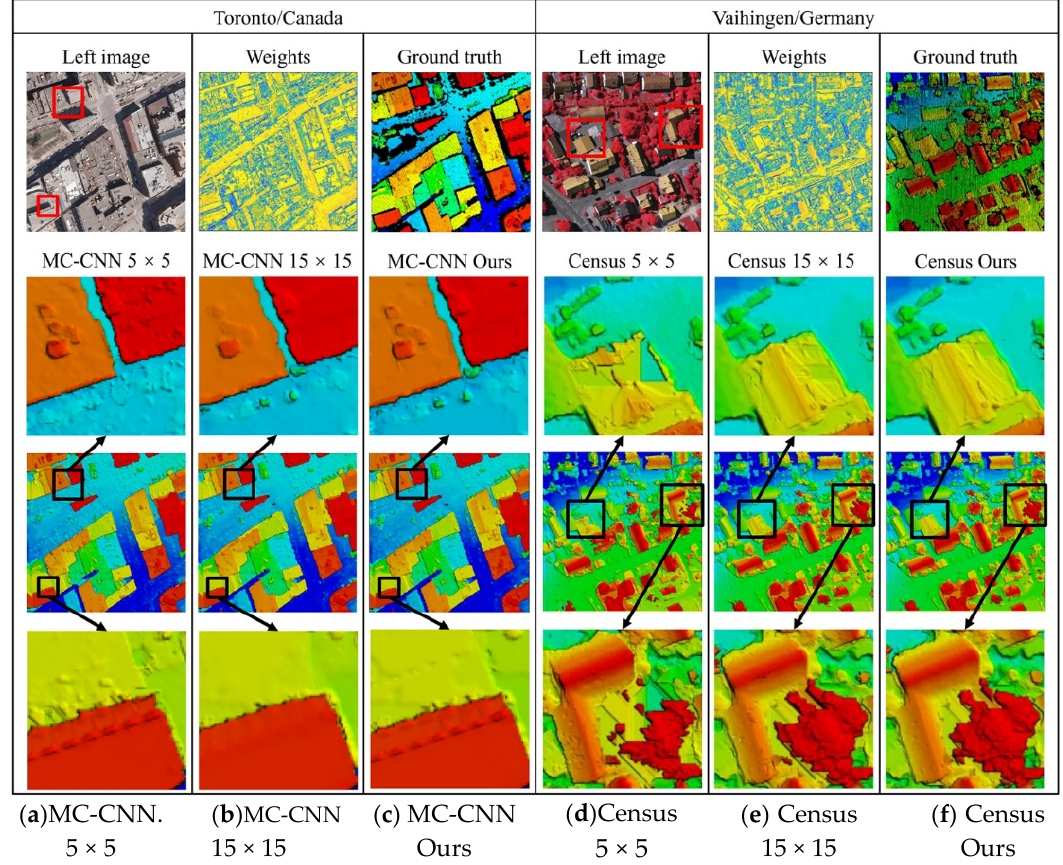
Figure 5. Examples of disparity images on the aerial dataset.